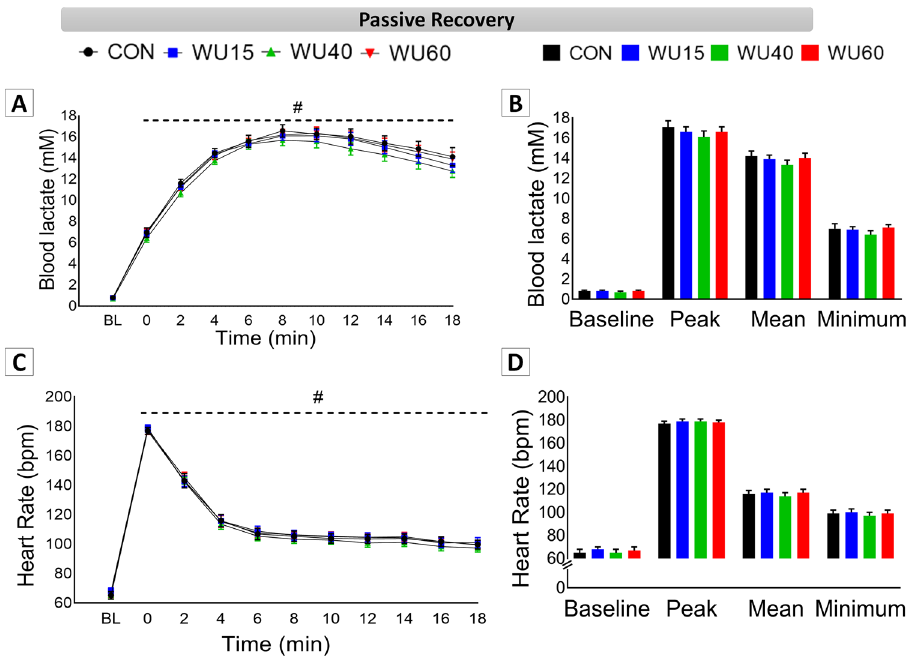
Figure 4. Physiological results of passive recovery immediately after the 30 s all-out run and every 2 min up to 18 min (mean ± EPM). Results under control conditions (CON, black color) and after IMW protocols with loads at 15% (WU15, blue color), 40% (WU40, green color) and 60% of MIP (WU60, red color). # corresponds to difference in relation to baseline (BL) for each protocol. Dashed line means no differences among